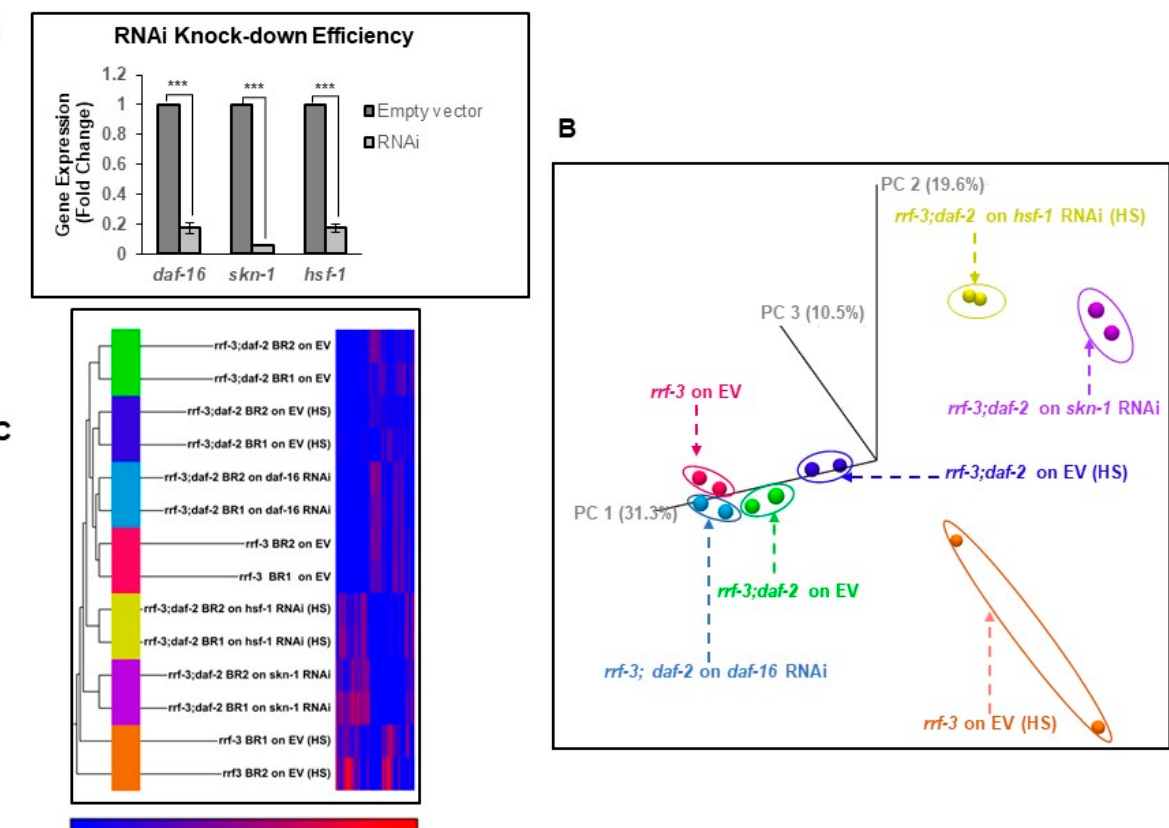
Figure A1. RNAi knockdown efficiency and data quality parameters. ( A ) RNA expression of the hsf-1 genes was reduced by 80%, while for skn-1 genes, it was reduced by more than 90%. ( B ) Principal component analysis (PCA) provides insights into the association between biological replicates. ( C ) Unsupervised hierarchical condition tree analysis clustered all the biological replicates under the same branch indicates a high degree of reproducibility with similar gene expression between biological replicates. *** p ≤ 0.001 .